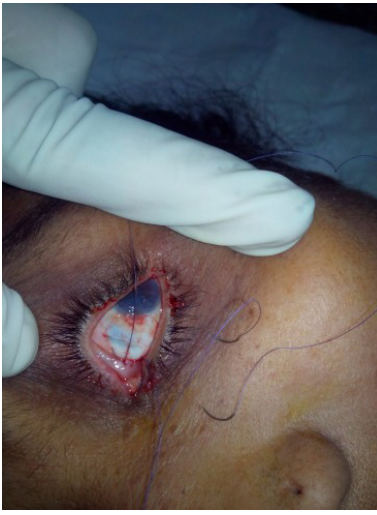
Figure 1. Suture material with needle in situ present over medial canthus of left eye